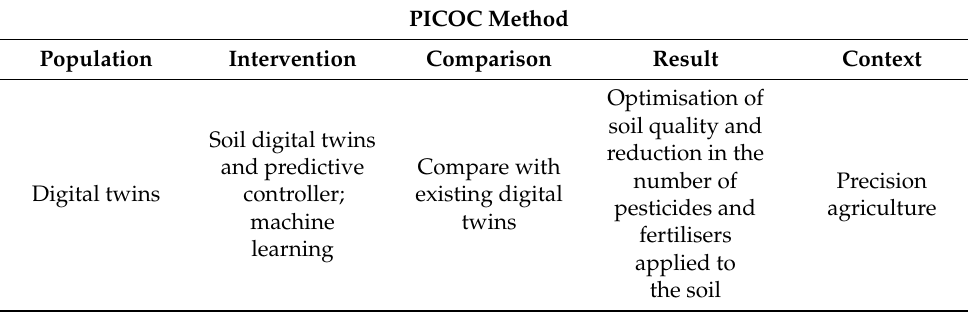
Table 2. The PICOC